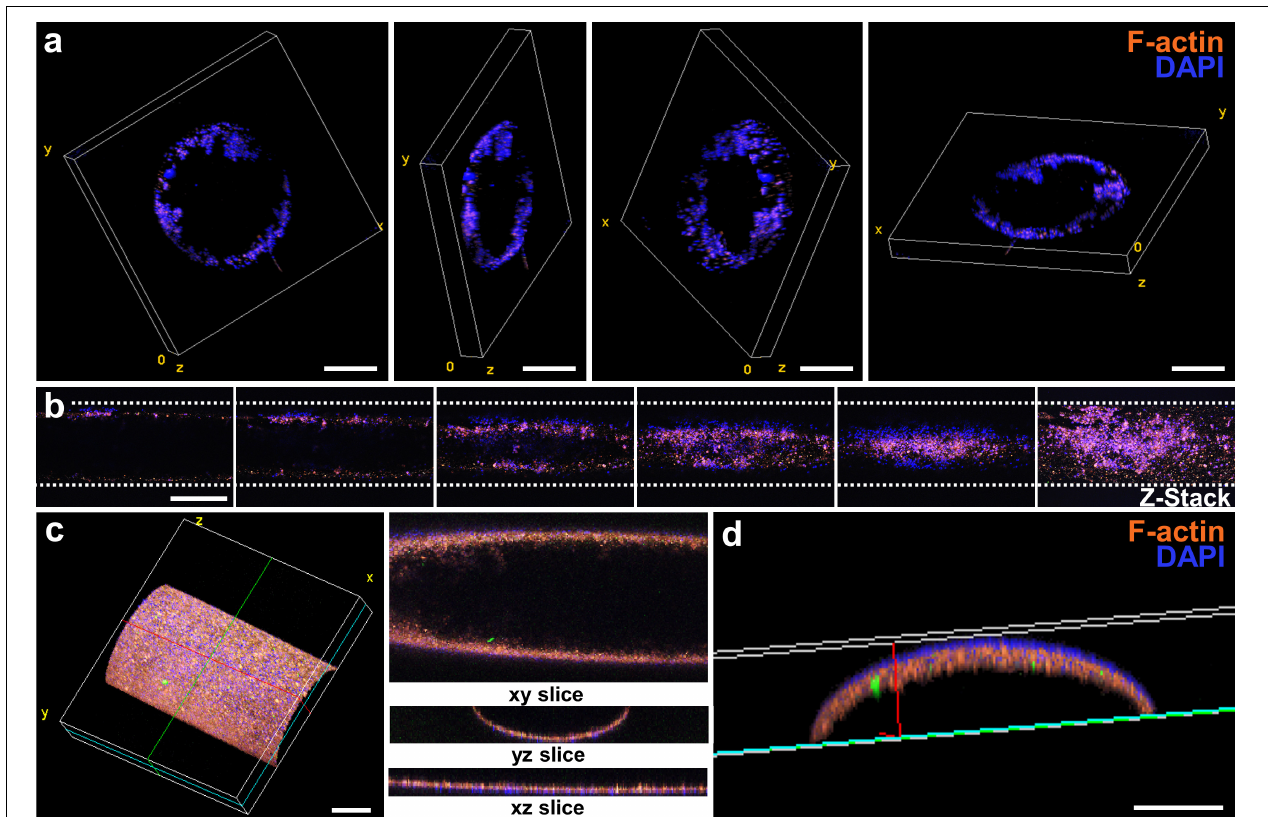
FIGURE 5 | Endothelialization of the luminal wall of the chip. (a) Sequence of cross-sectional confocal images showing the position of HUVECs seeded within the channel. Scale bars represent 250 µ m. (b) Sequence of confocal images taken lengthwise to the channel. The image at the far-right shows a z-stack projection of the sequence of images at varying z heights. Scale bar represents 500 µ m. (c) 3D projection of an endothelialized channel showing the cross-section views at the xy, yz, and xz planes. Scale bar represents 250 µ m. (d) Cross-section yz view of (d) . Scale bar represents 100 µ